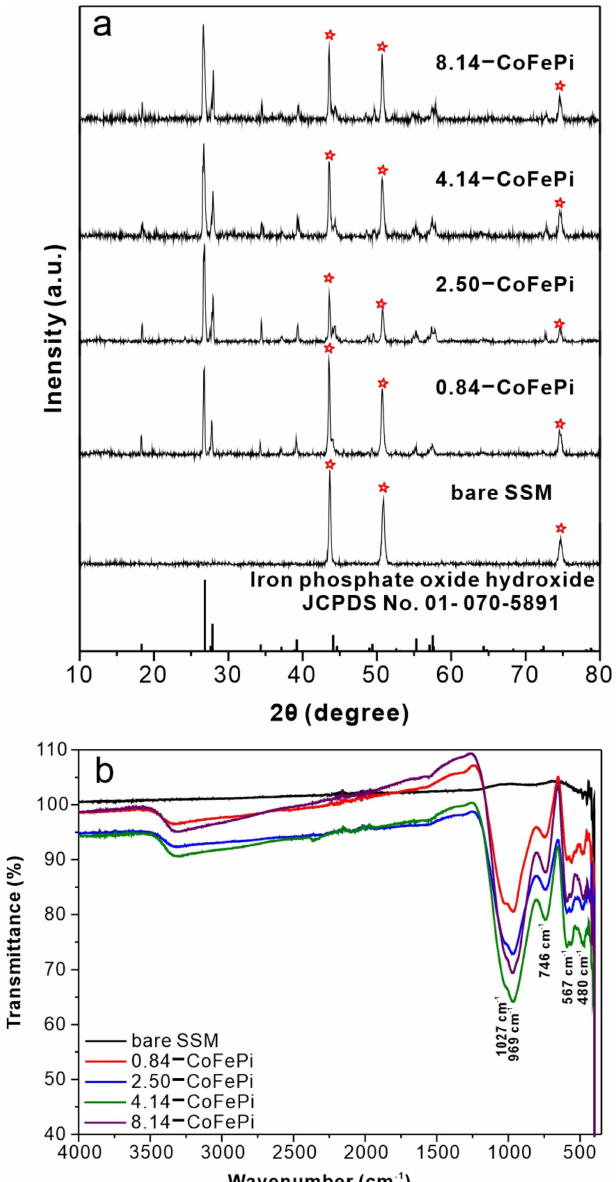
Figure 2. ( a ) X-ray diffraction patterns of 0.84-CoFePi, 2.50-CoFePi, 4.14-CoFePi, 8.14-CoFePi, bare SSM and iron phosphate oxide hydroxide (JCPDS No. 01-070-5891, peaks marked with red stars rep- resent the XRD peaks from bare SSM); and ( b ) FT-IR spectra of 0.84-CoFePi, 2.50-CoFePi, 4.14-CoFePi, 8.14-CoFePi and bare SSM.